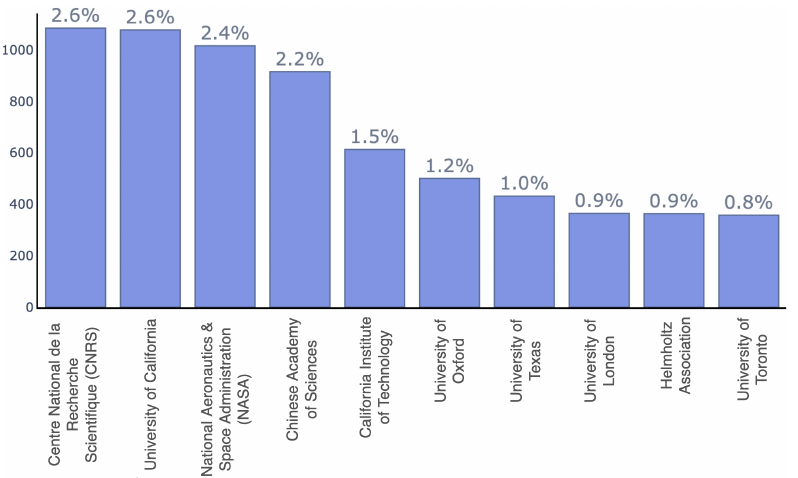
Figure 7. The institutions with more citations from the WoS-filtered results. The vertical axis represents the number of citations. The percentages above the bars indicate the relative frequency of each institution in terms of